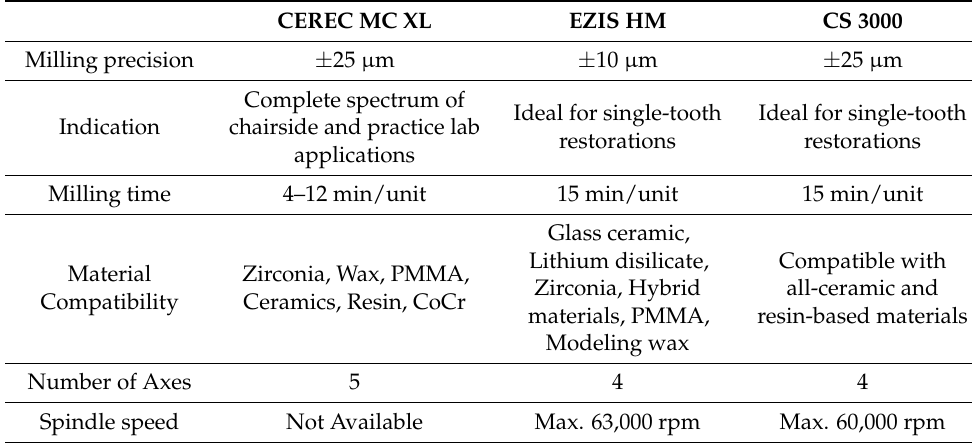
Figure 2. Crown design process using computer-aided design and manufacturing software with the EZIS system. ( A ) Selection of teeth to be restored; ( B ) design of margins and insertion axes; ( C ) se- lected crown from the proposed library; ( D ) crown modeling; ( E ) numerical values as parameters; ( F ) crown alignment for milling. Table 1. Features of each milling machine according to the